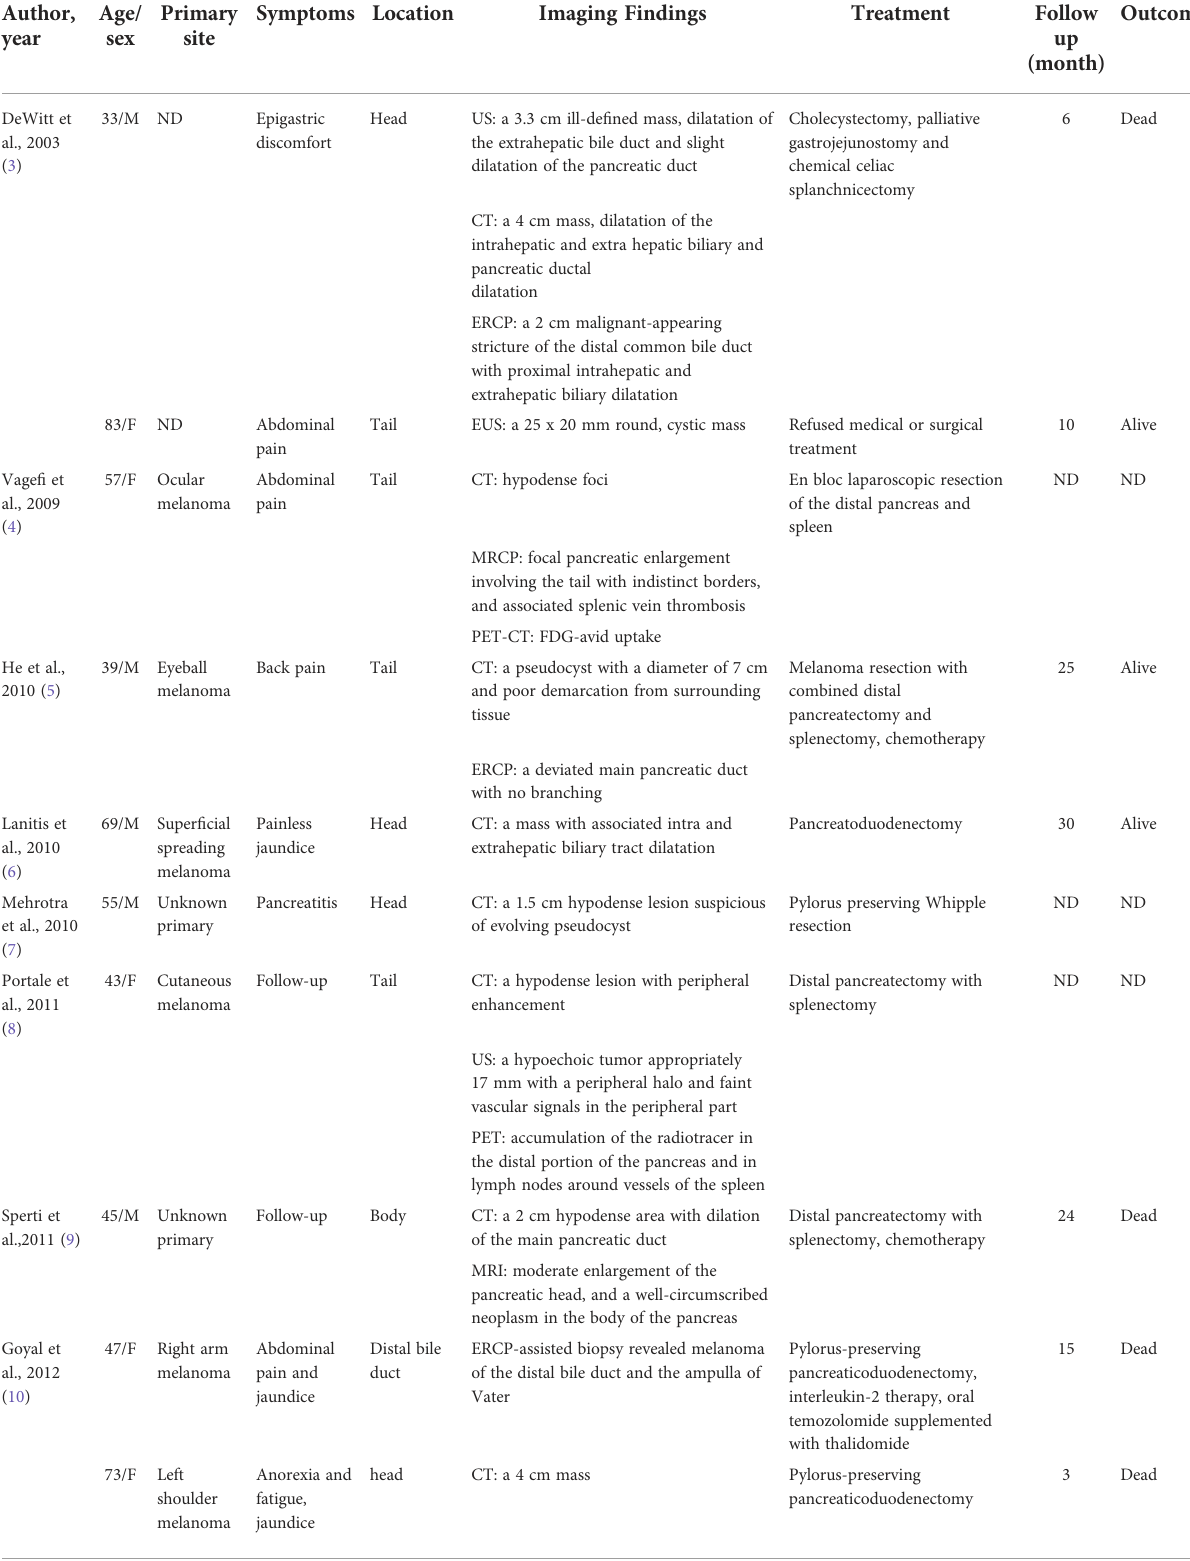
TABLE 1 Pancreatic melanoma in the literature between 2000 and 2021. Author,